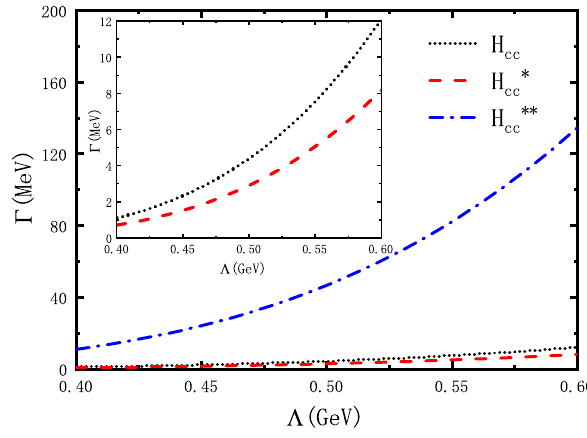
Fig. 3 Decay widths of H ( ∗∗ ) c → (cid:3) + c (cid:3) + c as functions of the cutoff